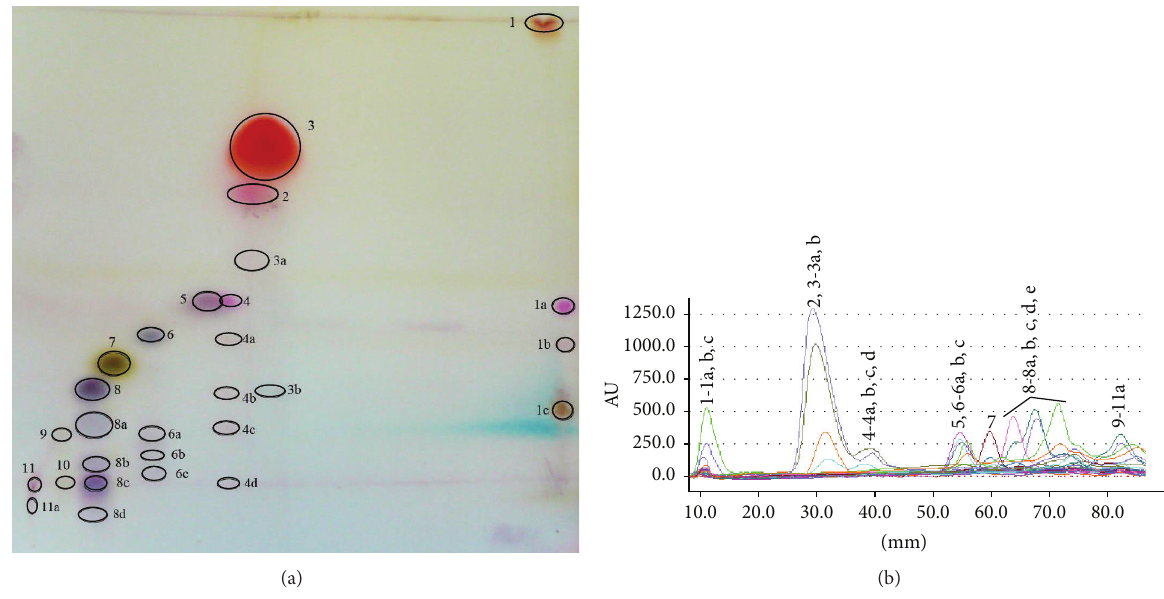
Figure 4: (a) MGD-2D TLC chromatogram presenting the separation of Thymi Oleum compounds. The eluent gradient program for second dimension development is presented in Table 2. Solutes were derivatized with the anise aldehyde-sulphuric (VI) acid reagent. (b) Overlaid densitograms of the Thymi Oleum separations into additional bands by means of MGD-2D TLC. The eluent gradient program for second dimension development from Table 2.